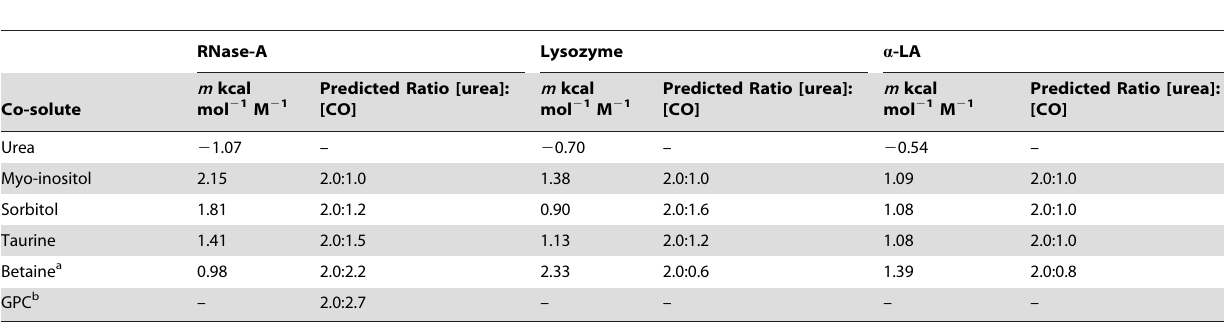
Table 2. m -values (dependence of D G Do on concentrations of different co-solutes) and the ratios, [urea]: [CO] predicted for perfect counteraction using equation 5 for RNase-A, lysozyme and a -LA at pH 7.0 and 25 u C.